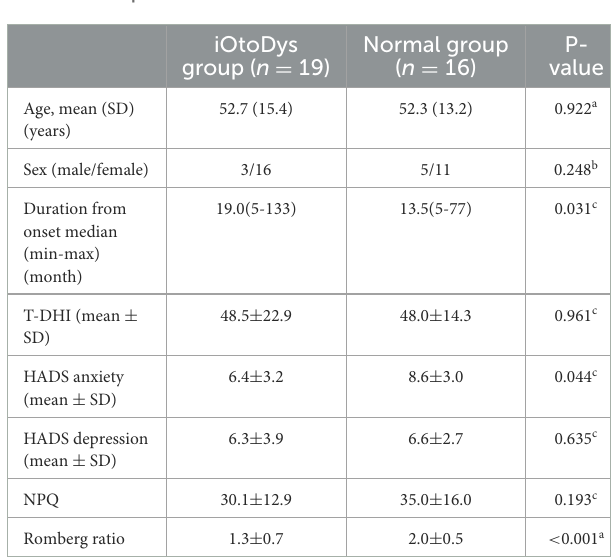
TABLE 2 Basic patient